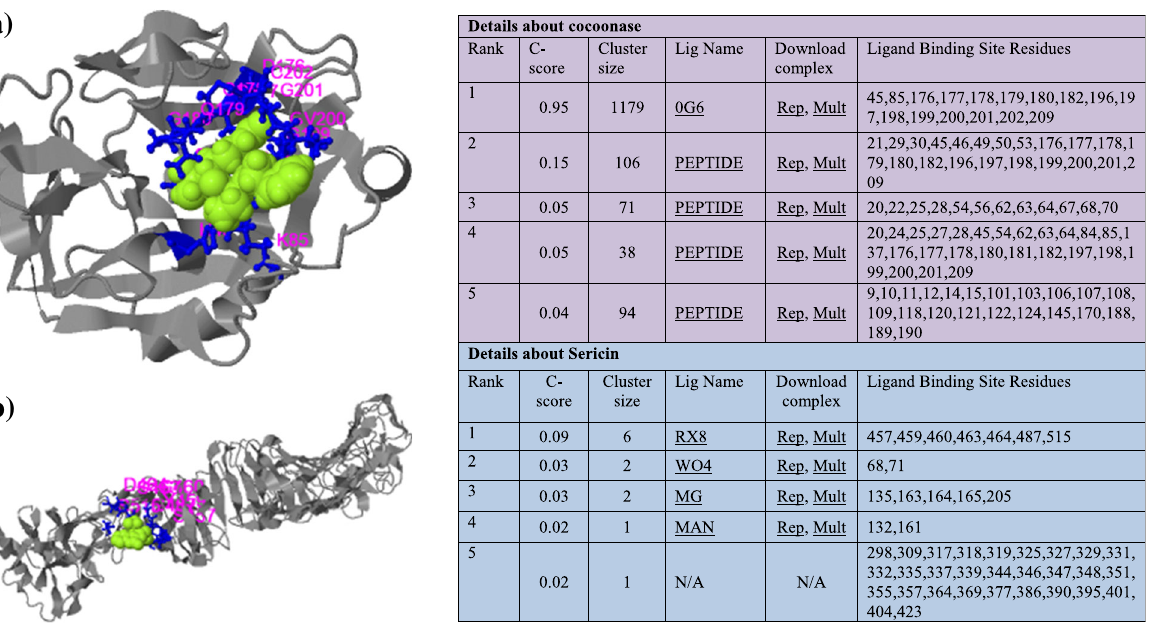
Fig. 6 The predicted ligand-binding sites in cocoonase ( a ) and sericin ( b ). The first functional template (PDB ID: 5jbcS) has a high confidence score (C-score = 0.95) for cocoonase which is showing the structure is stable and functional. The template (PDB ID: 3w3lA) for sericin has C-score of 0.09 which is also stable structure and will bind with a peptide ligand. But for the predicted peptide, the protein can likewise tie to different ligands, which are available in a PDB file at the “ Mult ”